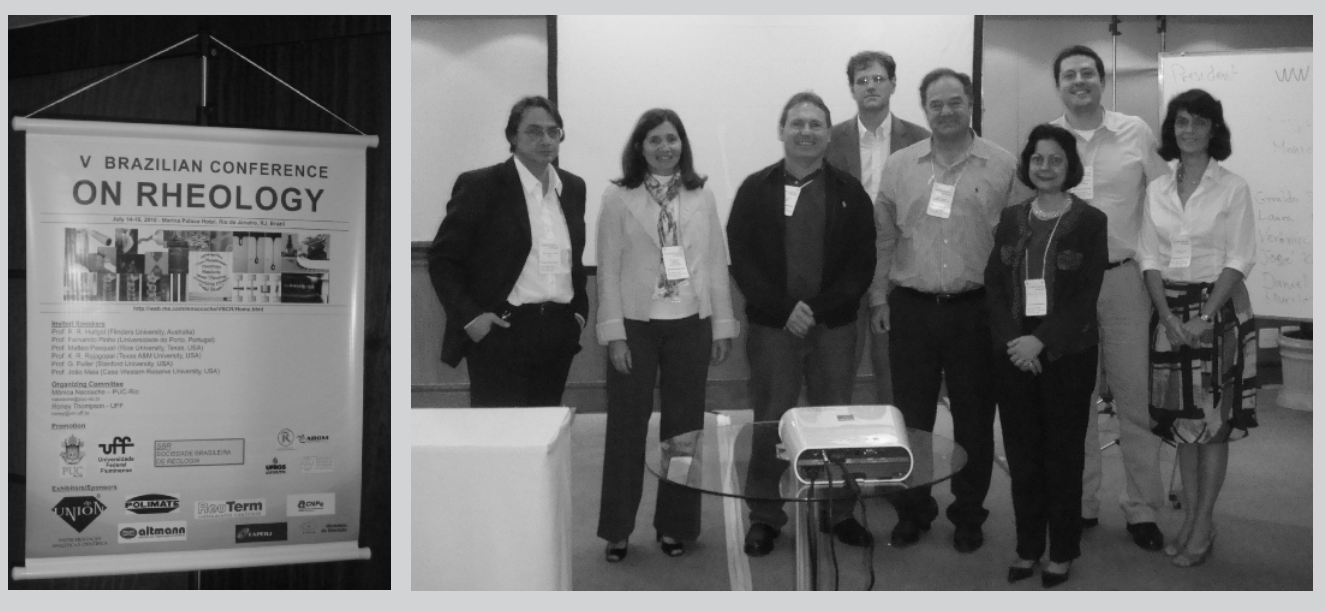
Figure 1 (left): The banner of BCR 2010. Figure 2: Launch of the Brazilian Society of Rheology (SBR) and first meeting (from the left to the right): Profs. J. Karam, M. F. Naccache, P. R. Souza Mendes (SBR Presi- dent), S. L. Frey, G. Fuller (ICR President), M. L. M. Costa, R. L. Thompson and V.